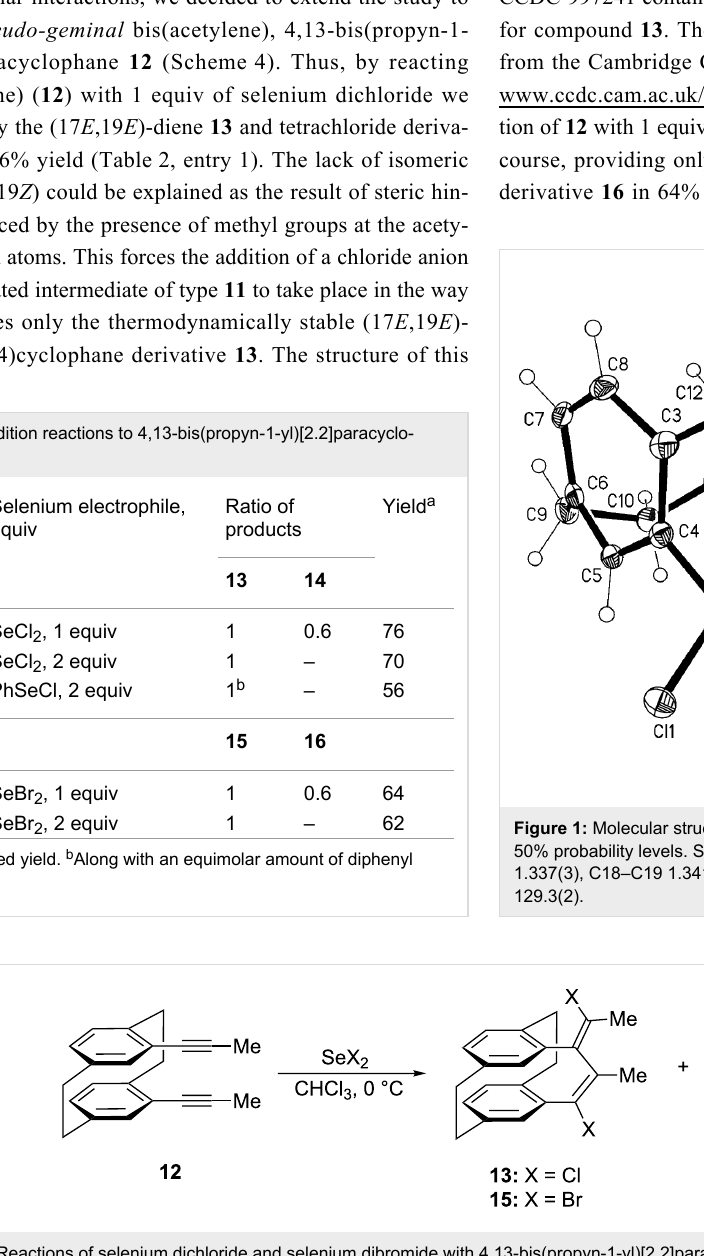
Scheme 4: Reactions of selenium dichloride and selenium dibromide with 4,13-bis(propyn-1-yl)[2.2]paracyclophane ( 12 ).